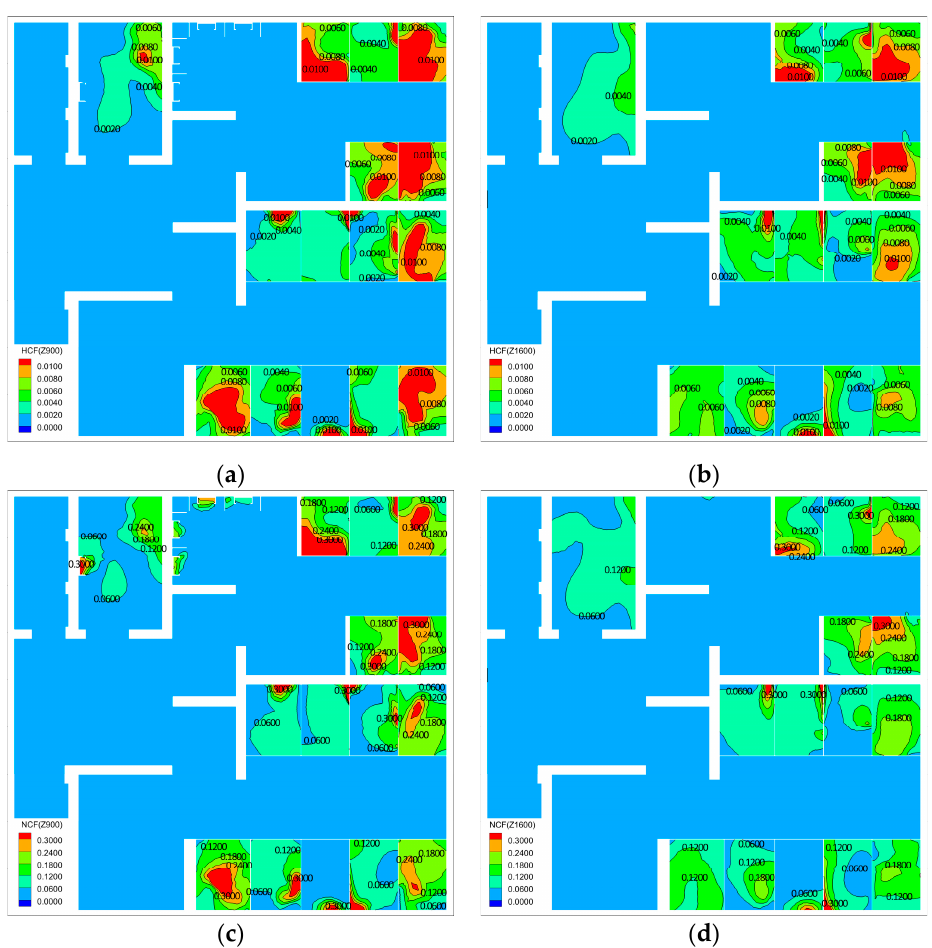
Figure 9. Concentration cloud map of pollutants in Scenario 8. ( a ) H 2 S concentration fraction (Z900); ( b ) H 2 S concentration fraction (Z1600); ( c ) NH 3 concentration fraction (Z900); ( d ) NH 3 concentration fraction (Z1600).